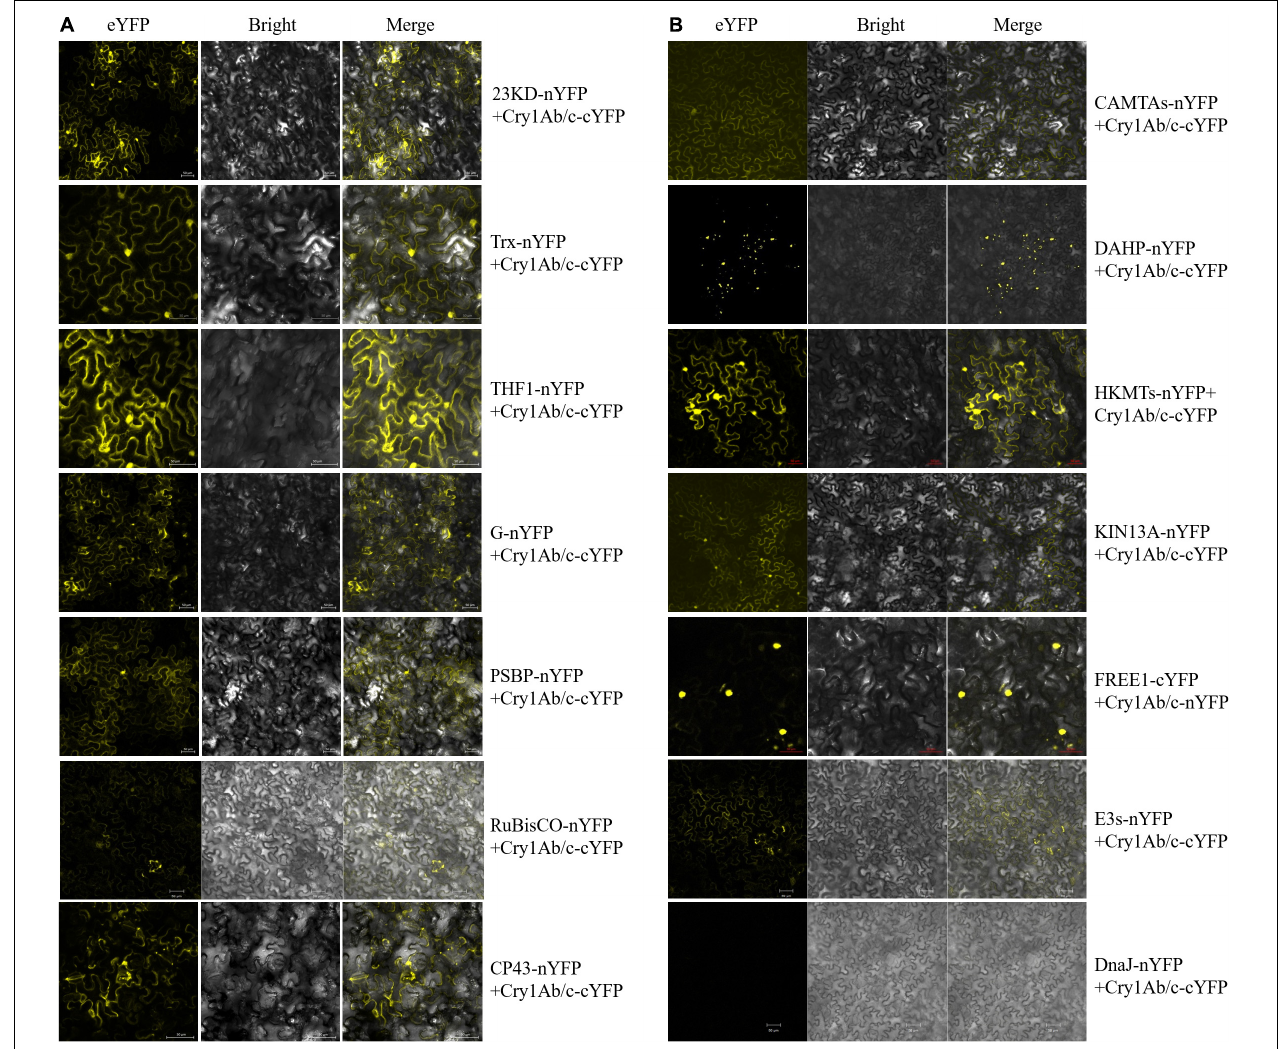
FIGURE 4 | The bimolecular fluorescence complementation was used to verify interactions between the full-length Cry1Ab/c protein and 14 photosynthesis and stress resistance proteins. The sites and strength of interactions between the Cry1Ab/c protein and photosynthetic (A) , stress resistance proteins (B) were determined by in situ YFP fluorescence, scale bars: 50 µ